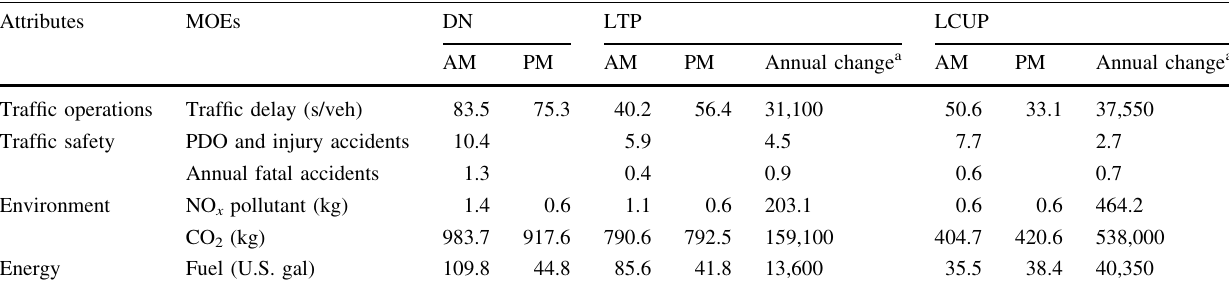
Table 3 Performance analysis results of LTP and LCUP Attributes